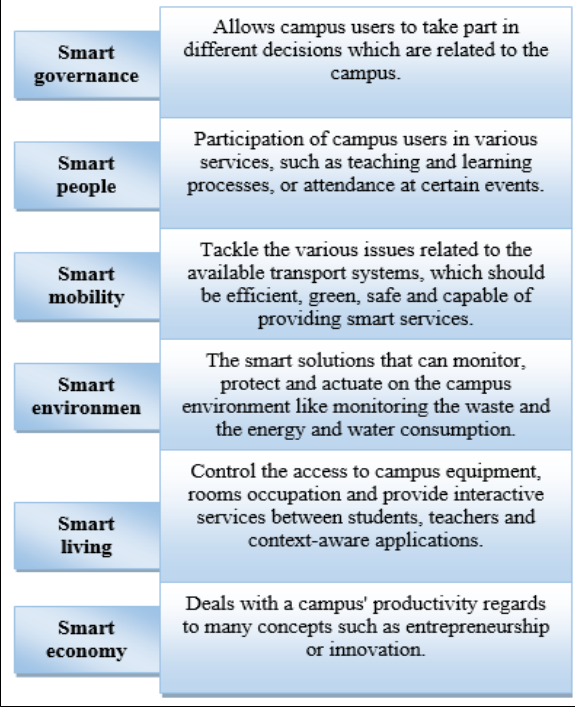
Figure 1. Smart Campus